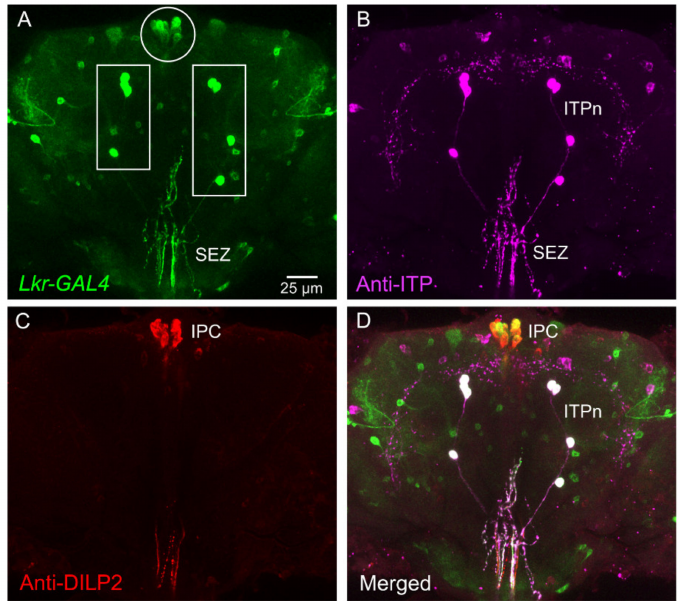
Figure 4. Expression of leucokinin receptor ( Lkr ) in identified neurons of the adult Drosophila brain. ( A ) Lkr -Gal4 expression in the brain and subesophageal zone (SEZ). The boxed areas contain ALKs (ALK/ITPn) and the encircled area shows the insulin-producing cells (IPCs). ( B ) Ion transport peptide (ITP) immunolabeling in the same brain. The ITPn that also express LK are indicated. ( C ) DILP2 (insulin-like peptide 2) immunolabeling in IPCs in the same brain. ( D ) Merging the three channels, it is clear that ITPn and IPC co-express Lkr -Gal4 (these are boxed and encircled in A, respectively). Figure reproduced from [38] with permission from the